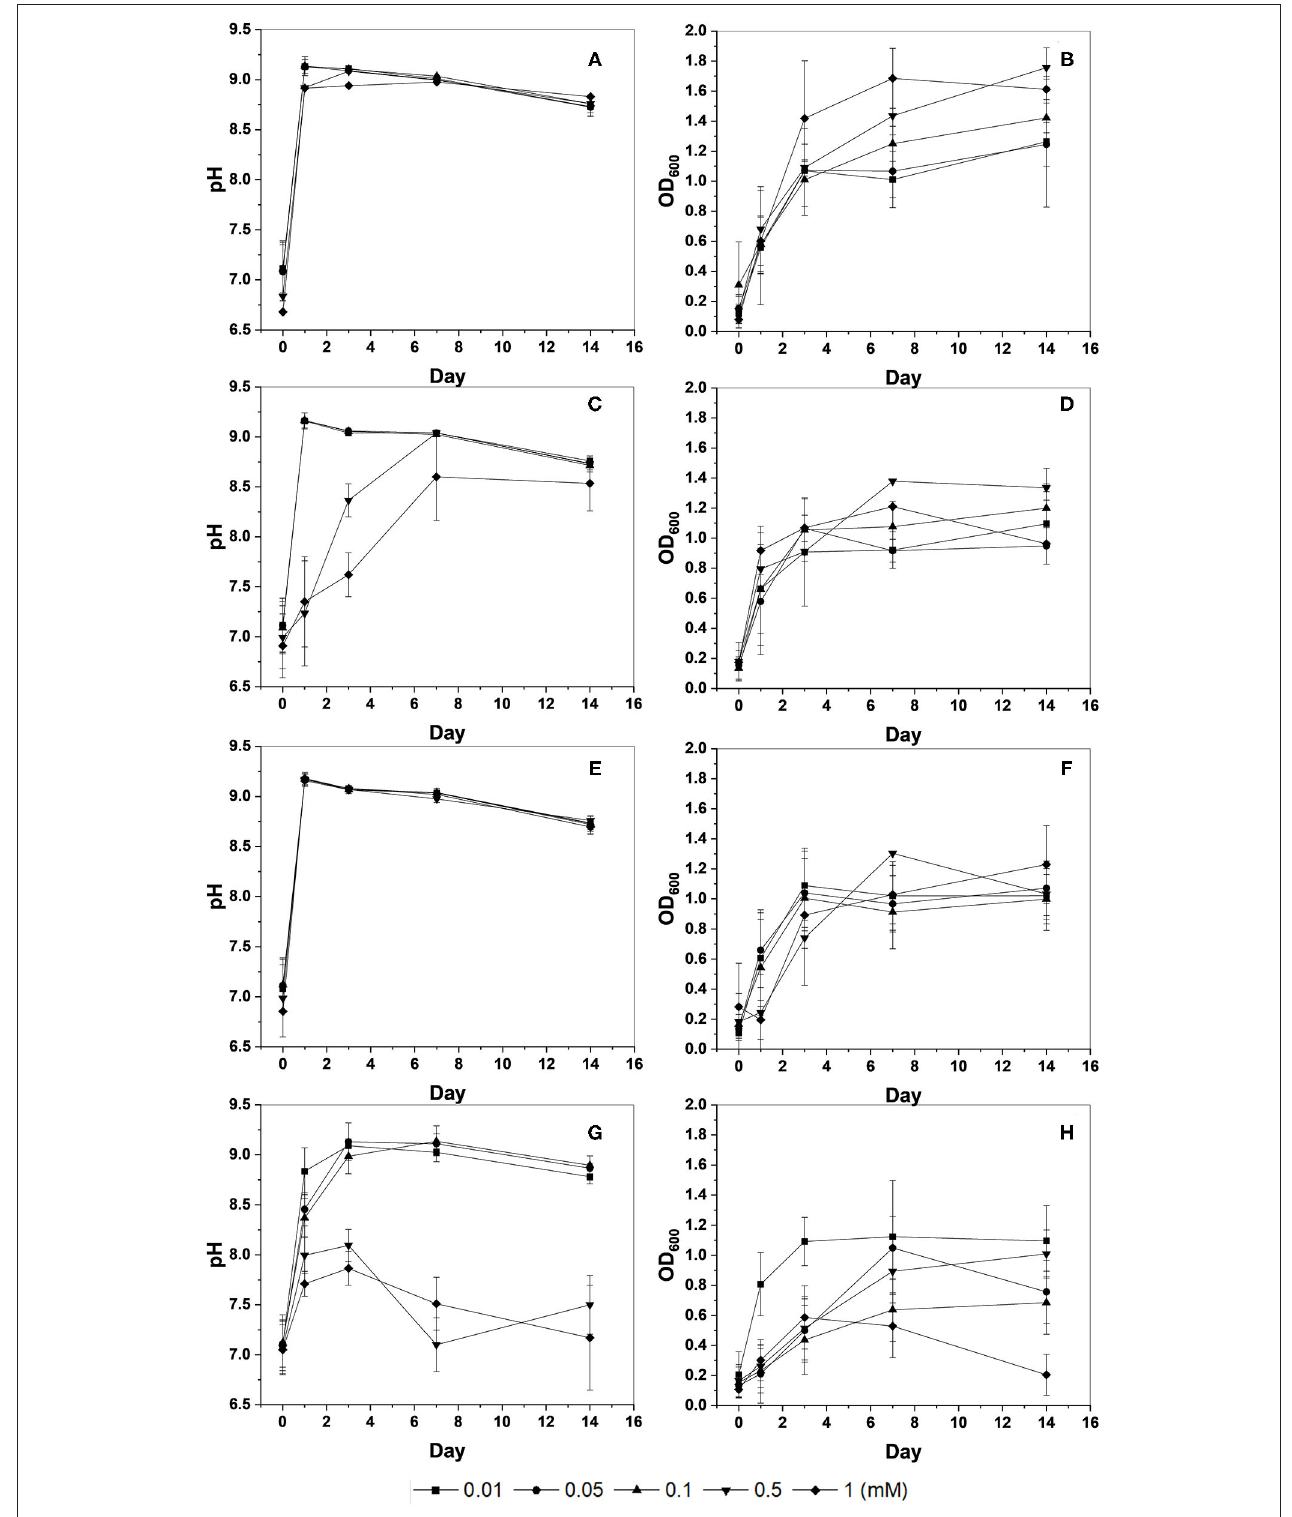
FIGURE 1 | Changes in pH and optical density (OD 600 ) of KCTC 3558 culture at various metal concentrations (mM): Cu (A,B) ; Zn (C,D) ; Pb (E,F) ; and Cd (G,H) .